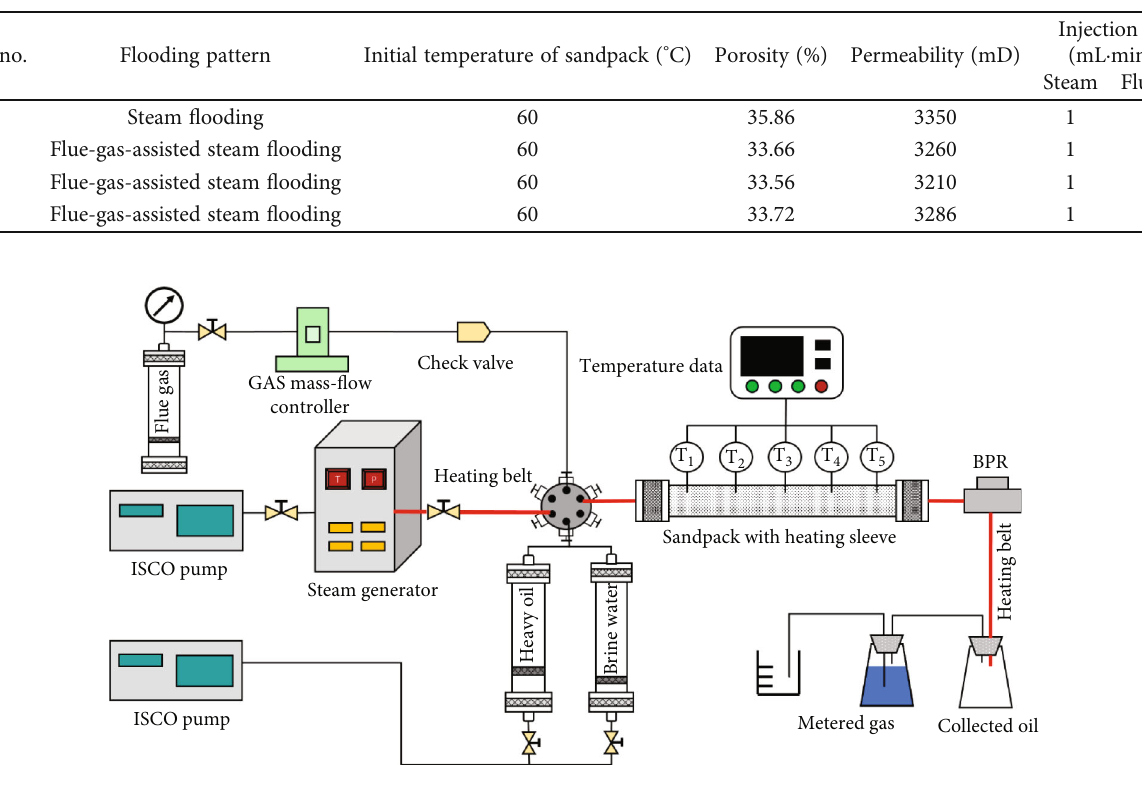
Figure 2: Flow chart of displacement experiment.